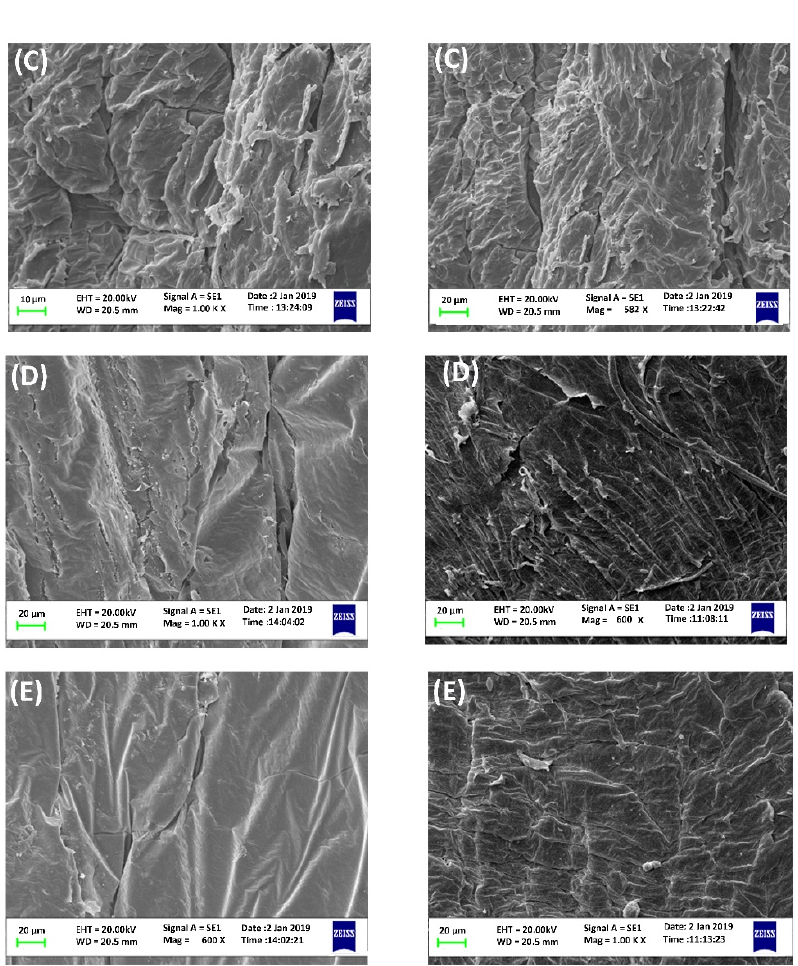
Figure 1. Scanning electron microscopy (SEM) micrograph at scale of 20 μ m for polyethylene (PE) biodegradation ( I ) epiphyton (EPP): ( A ) control treatment,( B ) EPP + near atmospheric methane (NAM) + PE, ( C ) EPP + 13 C (12% methane) + PE, ( D ) EPP + 13 C + M1C2 + PE, and ( E ) EPP + 13 C + M2C2 + PE. ( II ) Epixylon (EPX): ( A ) control treatment, ( B ) EPX + NAM + PE, ( C ) EPX + 13 C + PE, ( D ) EPX + 13 C + M1C2 + PE, and ( E ) EPX + 13 C + M2C2 +